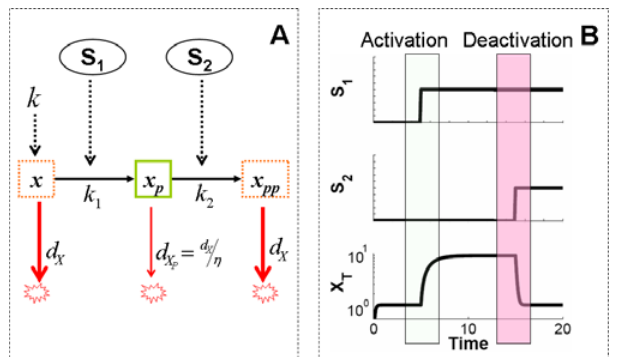
Figure 3. Dual-kinase module as a signal integrator. (A) The dual-kinase mechanism. S 1 and S 2 determine gain and loss of X stability by sequential phosphorylation, which in turn control the total amount of the target protein ( x T = x + x P + x PP ). k 1 and k 2 are the rate constants for are degradation phosphorylation by S1 and S2, respectively. d X and d X P rate constants of the unstable ( X or X pp ) and stable ( X p ) forms of X. (B) Given sufficiently strong input signals S 1 and S 2 , the dual kinase mechanism integrates upstream activating signal S 1 to turn on, and deactivating signal S 2 to turn off. The time delay between the two signals controls the duration of activation.